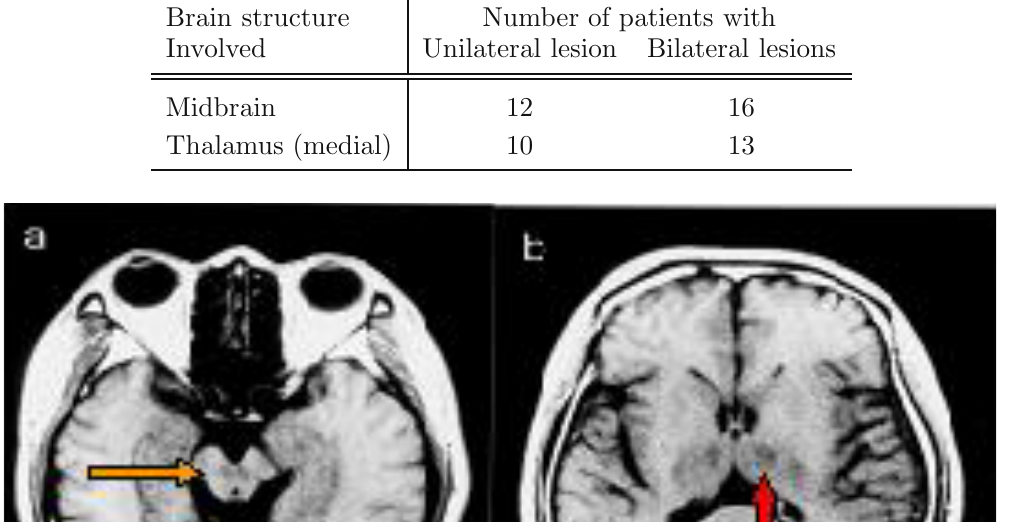
Table 2 Laterality of neuroimaging results for 28 patients with paramedian mesencephalic artery syndrome.